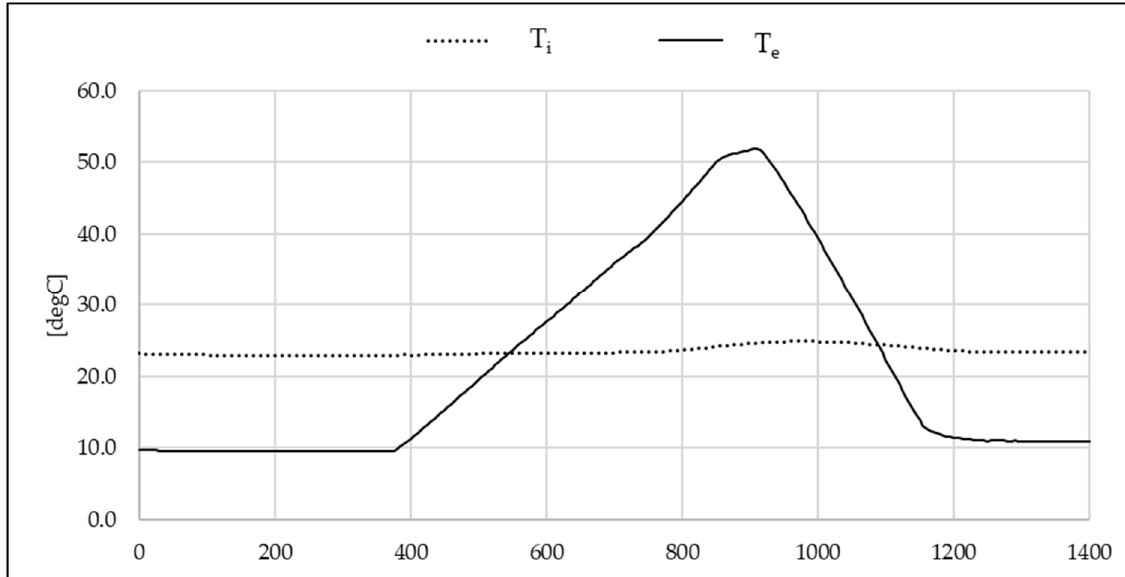
Figure 5. Temperature history of the experiment.